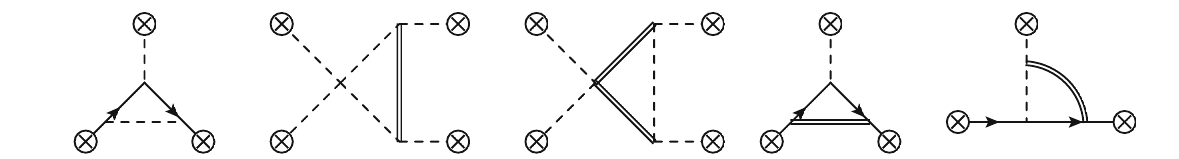
pling. They are only present in the quantum gravity context. The last twodiagrams give a quantum gravitycorrection totheYukawa